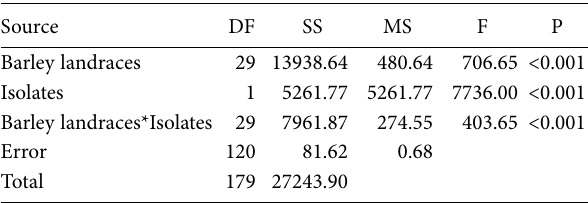
Table 3. Analysis of variance for the resistance of 30 barley landrac- es 45 d after planting following seed inoculation with two isolates of Drechslera graminea .